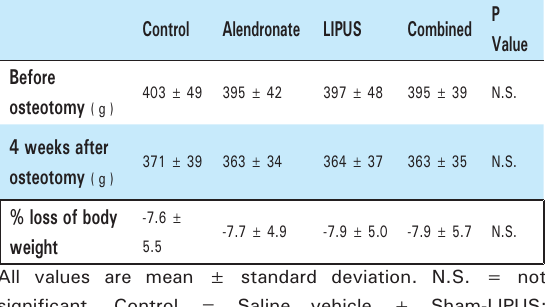
Table1. Body weight changes in rats